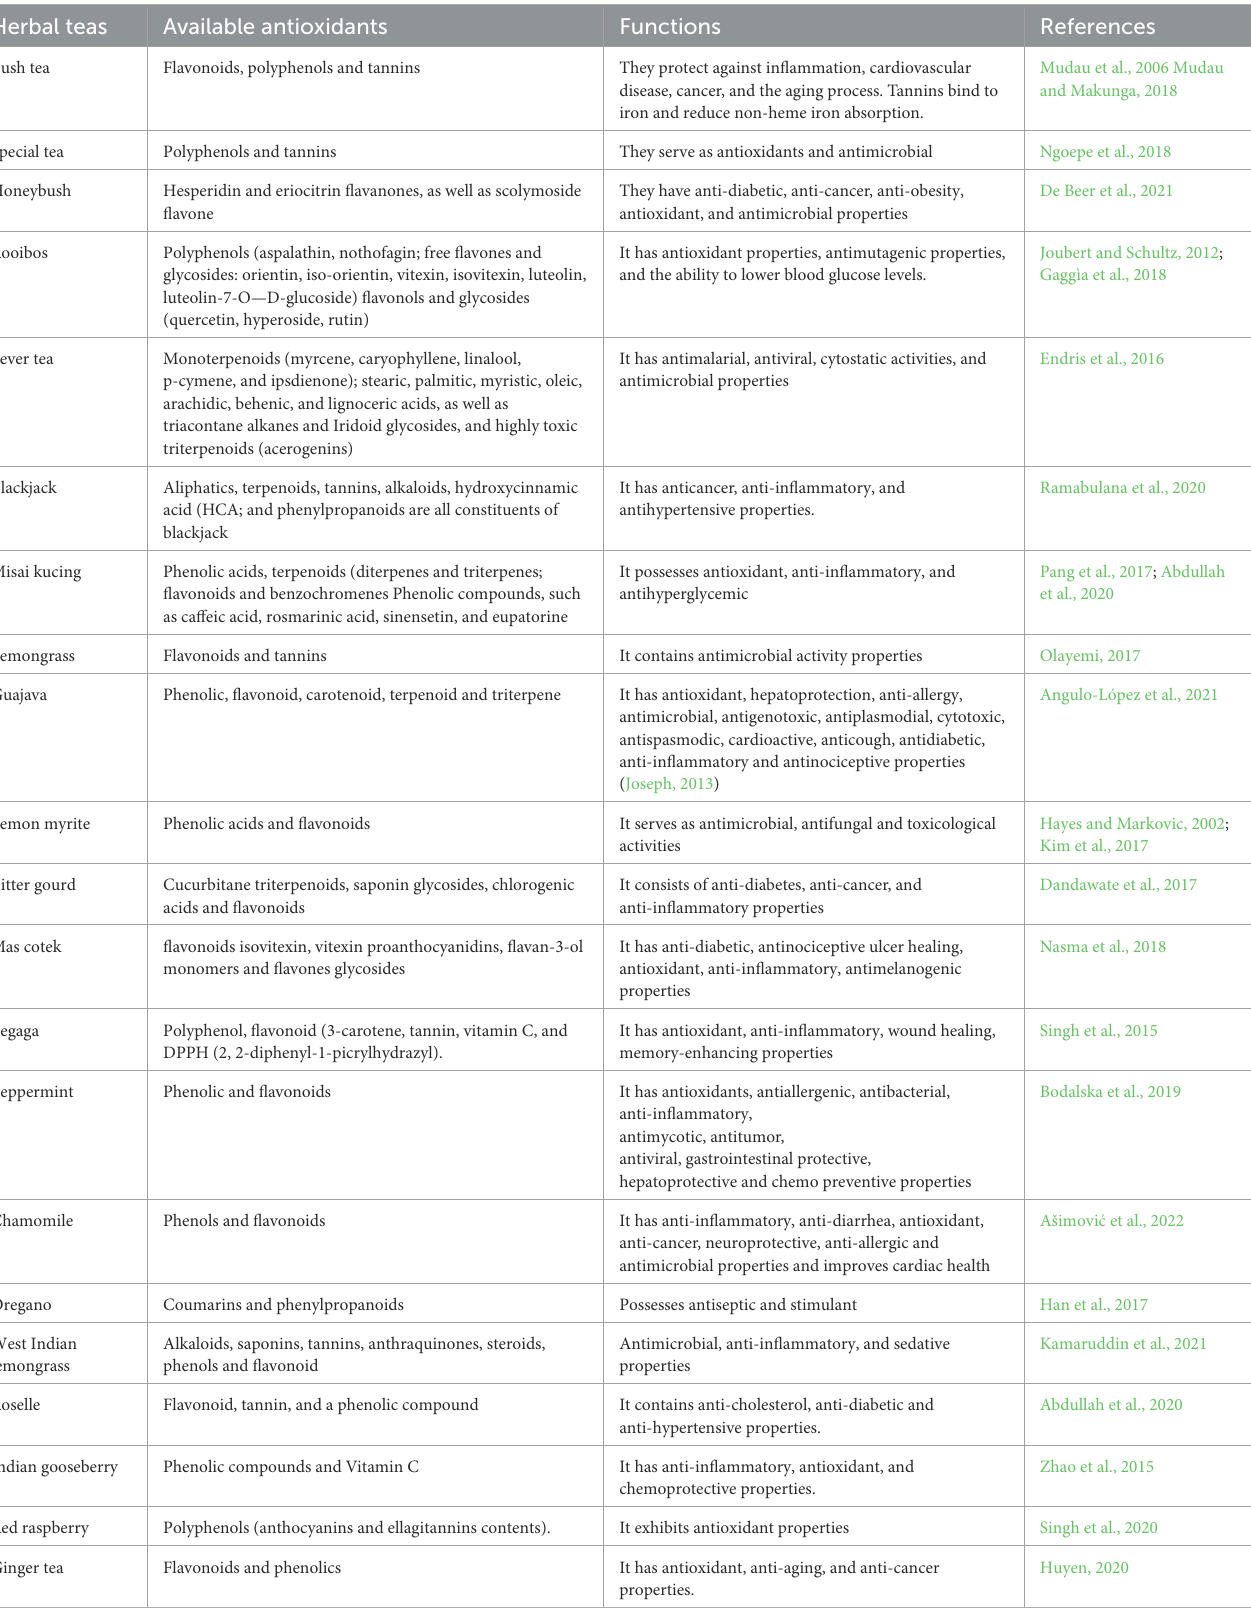
TABLE 2 Different types of herbal teas and their health